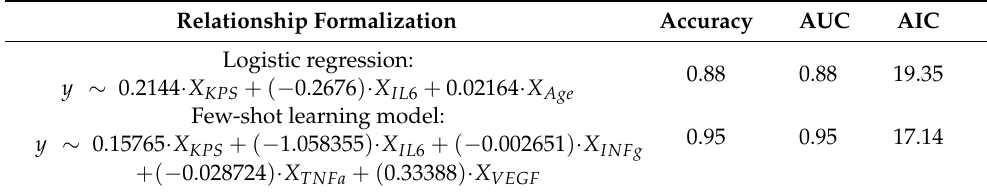
Table 5. Suggested regression models for analysis of the relationship between clinical characteristics and local control